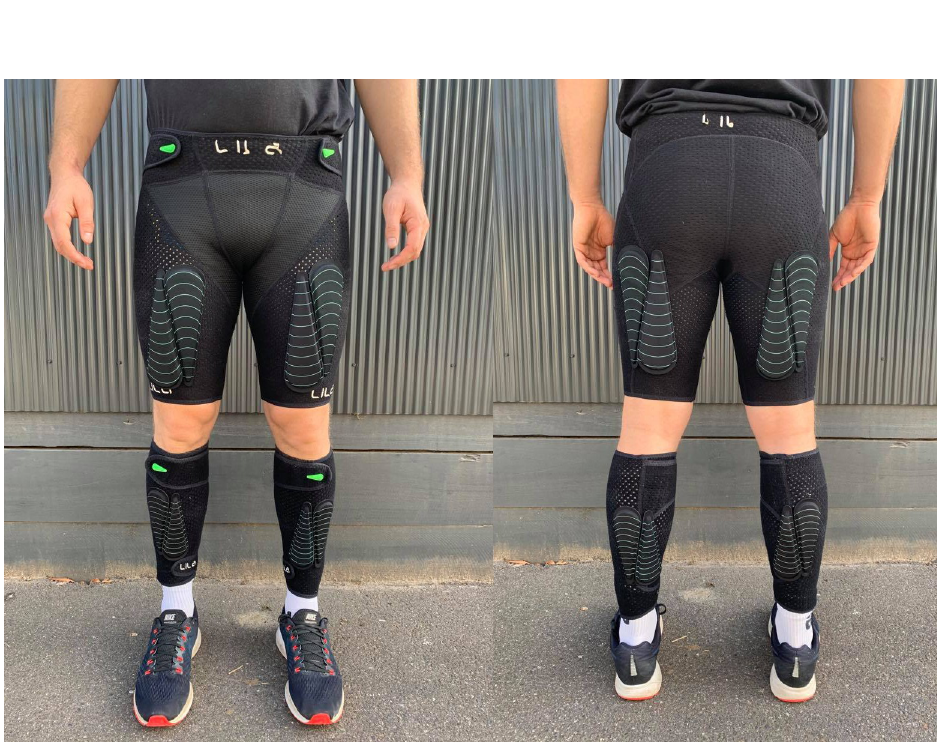
Fig 2. Lila ™ Exogen ™ compression shorts and calf sleeves with thigh and shank loading.